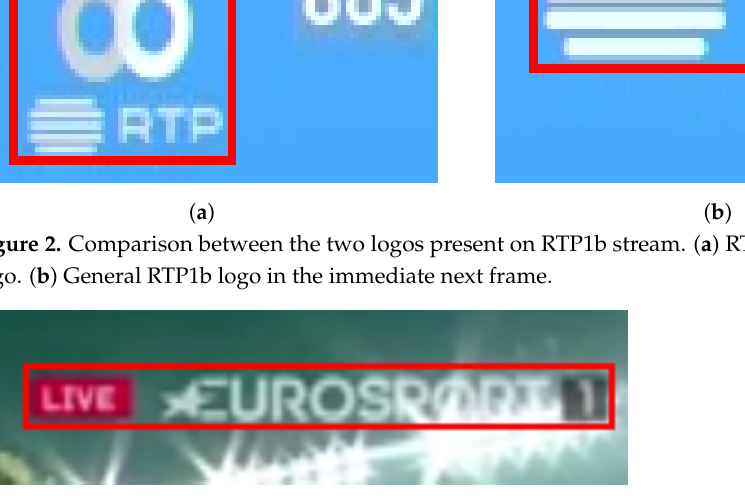
Figure 3. Eurosport logo blended with the background as seen in the final part of the logo.